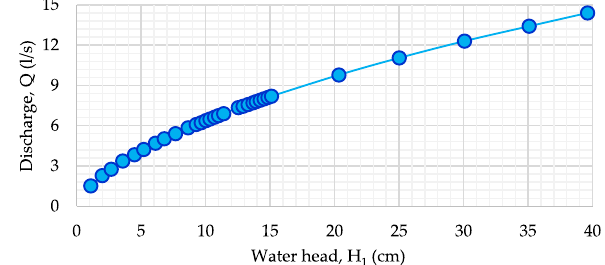
Fig. 2 Hydraulic jump types depending on Froude number (Peterka